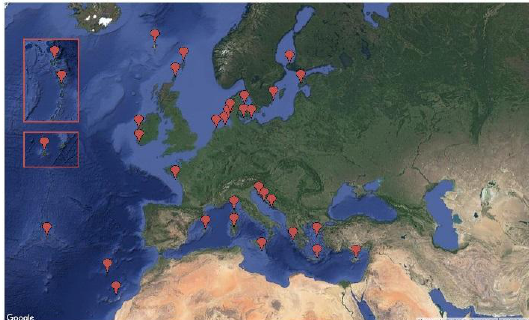
Figure 4: The EU initiative “smart islands”